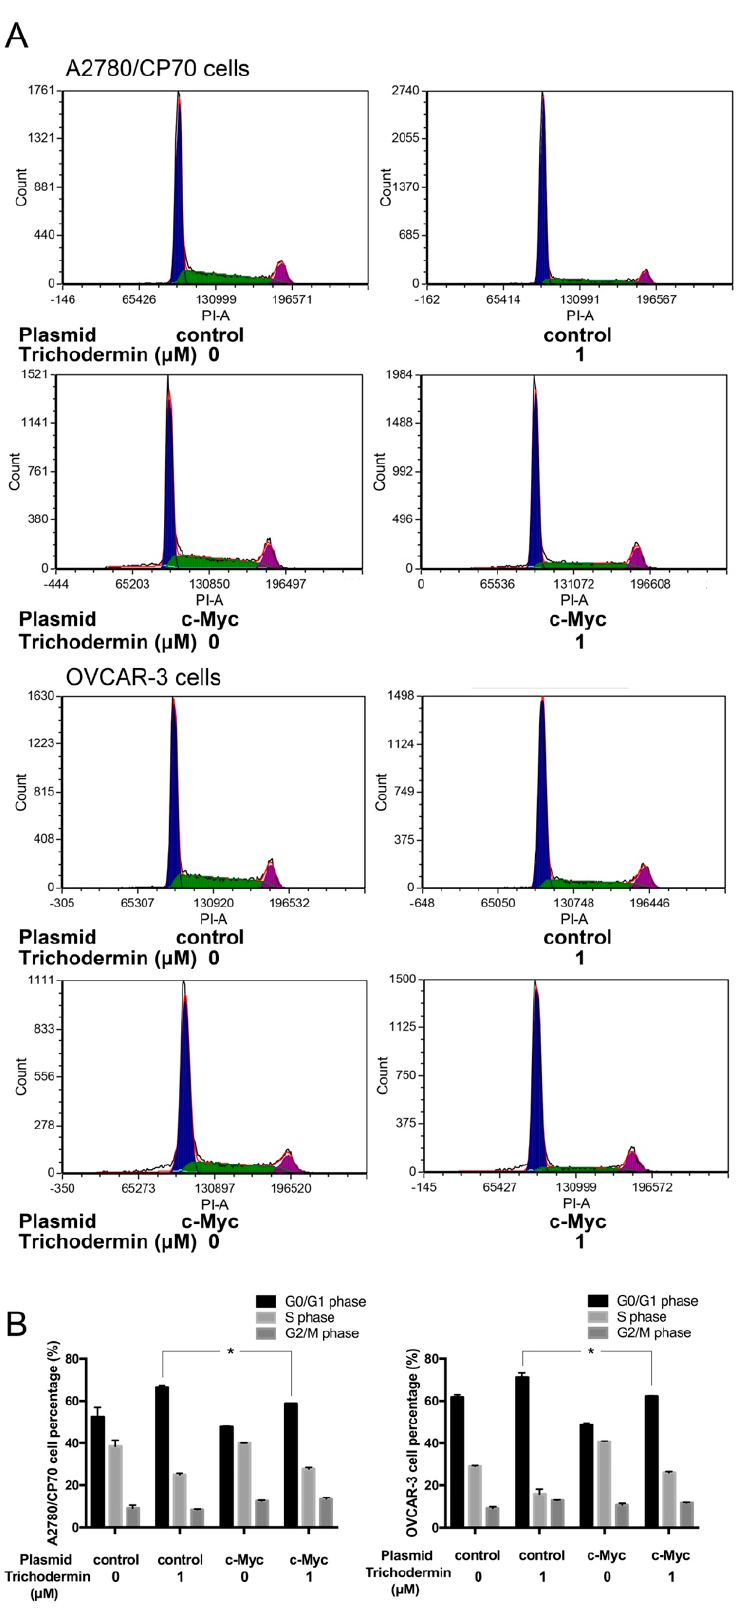
Figure 4. Overexpression of c-Myc attenuated trichodemin-induced G0/G1 cell cycle arrest in A2780/CP70 and OVCAR-3 cells. ( A ) Flow cytometry plots. ( B ) The cell cycle distribution of A2780/CP70 cells and OVCAR-3 cells after plasmid transfection and trichodermin treatment. * p < 0.05 compared with the specific group.